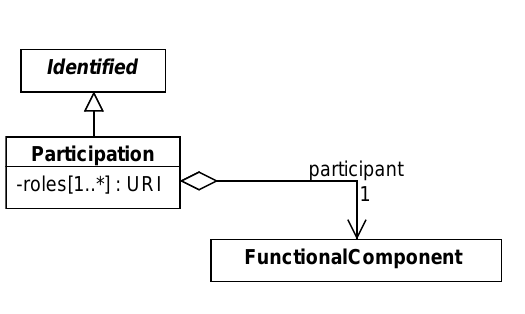
Figure 18: Diagram of the Participation class and its associated properties.